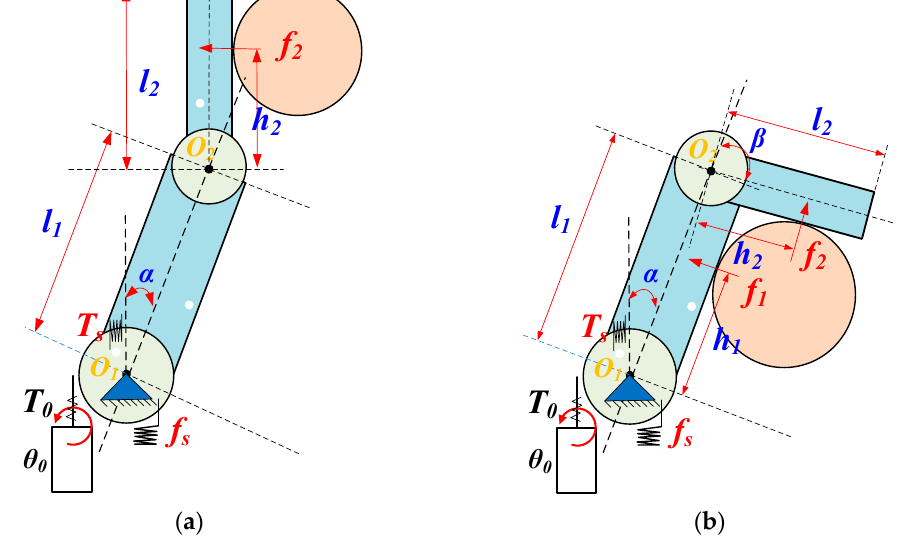
Figure 8. Mechanical analysis of the ESMGM hand (PASA mode): ( a ) Parallel grasping; ( b ) self- adaptive grasping.